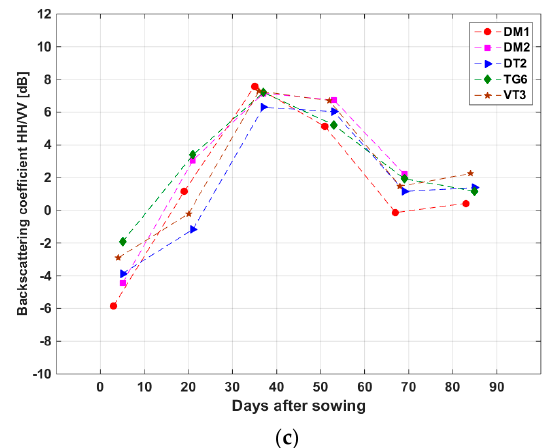
Figure 7. Variation of ( a ) HH, ( b ) VV backscattering coefficient, and ( c ) HH/VV of the five selected short-cycle sampled fields extracted from CSK images of six dates, versus the sowing date of each field.